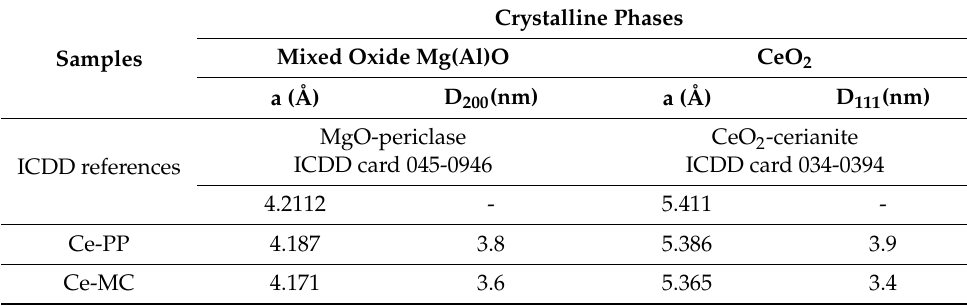
Table 2. The structural data for the calcined form of Ce-containing